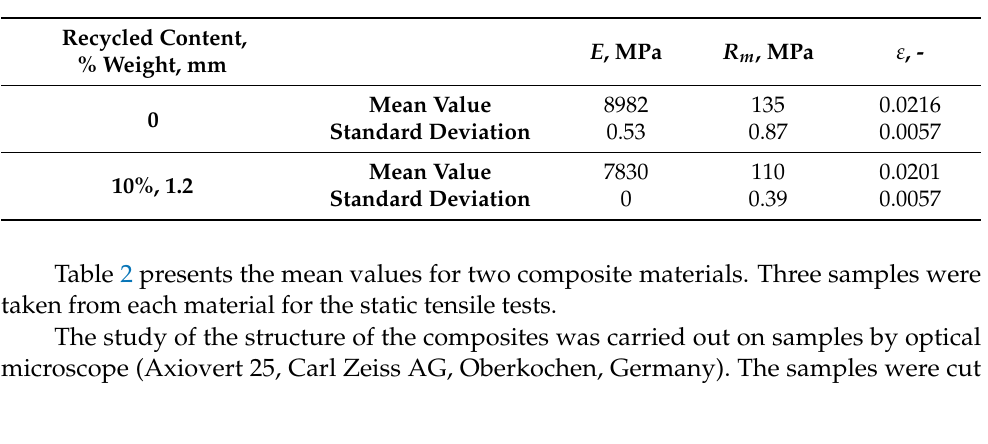
Table 2. Mean values of a static tensile strength test carried out on composite materials obtained from three samples taken from each